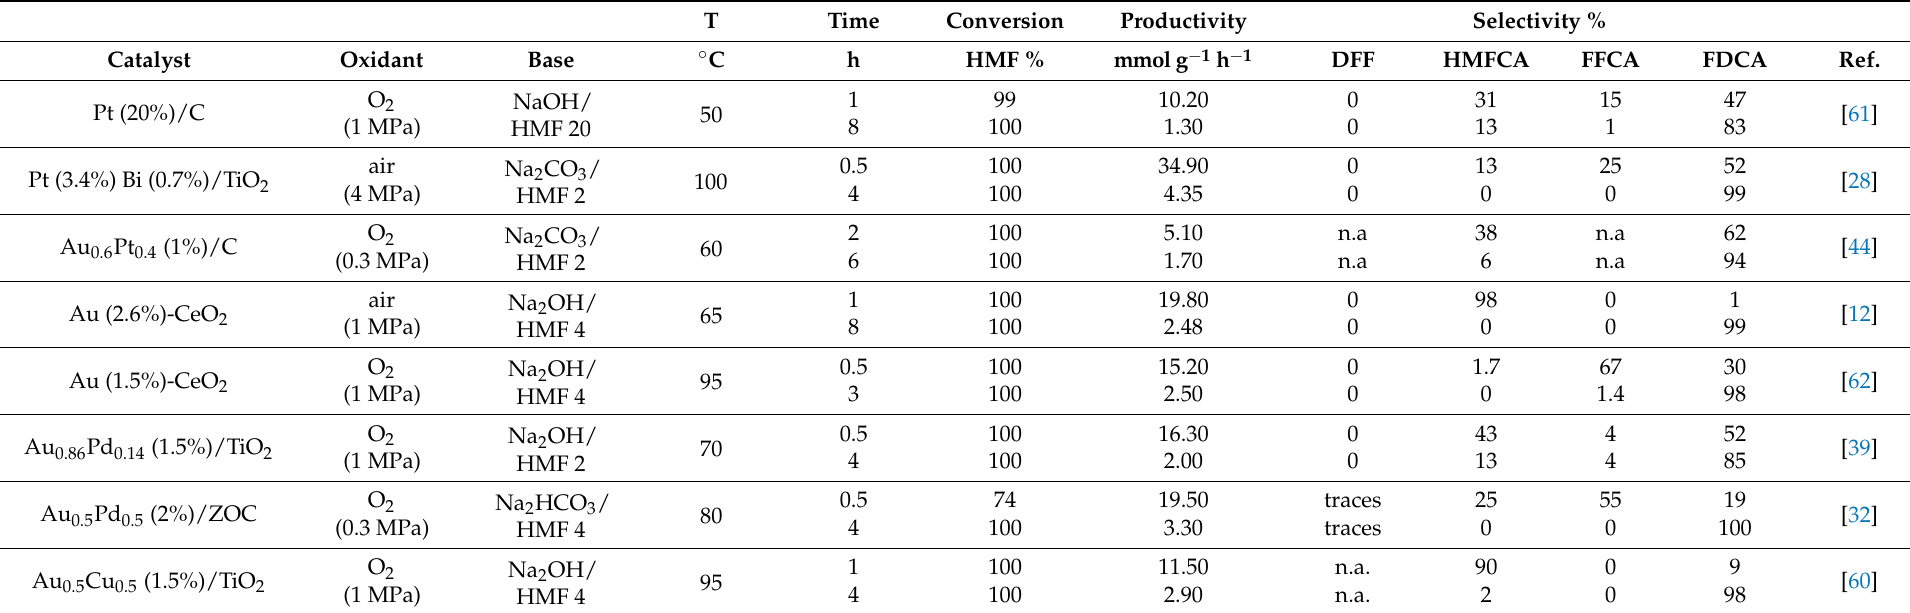
Table 2. Selected literature results of base-assisted HMF oxidation in water on supported noble metal